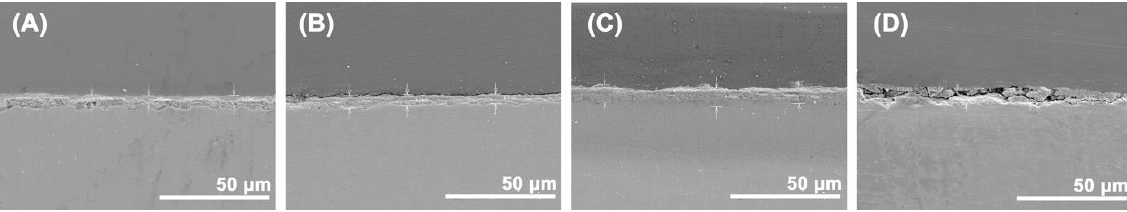
Figure 9. SEM of copper at different exposure times, magnification 100 × : ( A ) 3 months, ( B ) 12 months, ( C ) 24 months, and ( D ) 36 months. Front side. SEM of copper at different exposure times, magnification 100 ( B ) 12 months, ( C ) 24 months, and ( D ) 36 months. Front